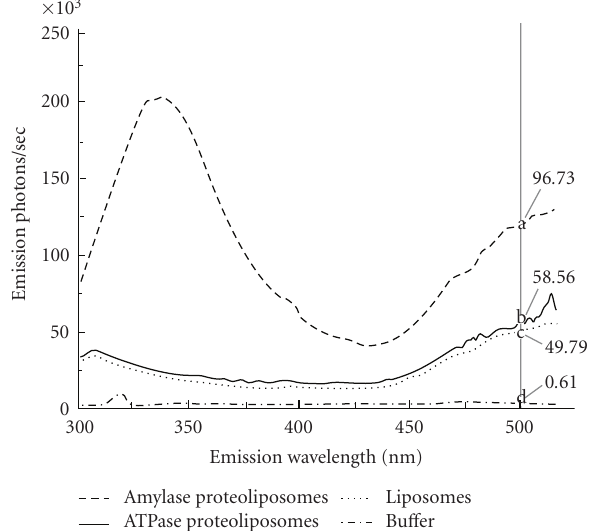
Figure 2: Fluorescence resonance energy transfer to detect ATPase incorporation. Typical fluorescence emission from a single scan of liposomes (dotted) and proteoliposomes containing amylase (dashed) or ATPase (solid) and bu ff er (dashed dotted). All lipo- somes were prepared by filtration, contained 2moL% dansyl, and were excited at 278 nm, the wavelength of excitation for tryptophan endogenous in the enzymes, and emission recorded over 300– 520nm; each preparation was scanned 3 times within 20 minutes. Mean emission intensities obtained from the three scans at 500 nm (grey vertical line), the wavelength of maximum emission of dansyl when excited by emitted light from nearby tryptophan, di ff ered significantly within each replicate (a, b, c, d; n = 3).